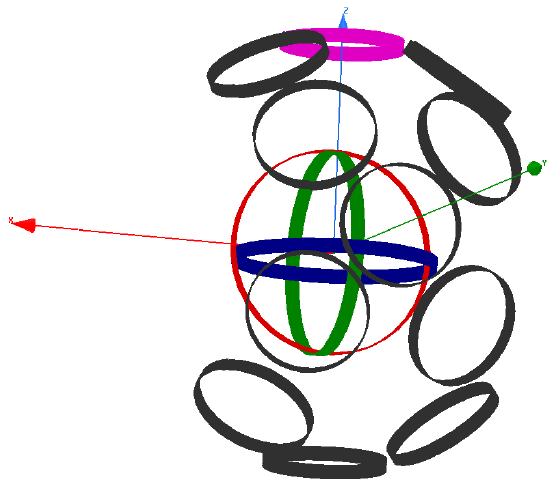
Figure 6. 3D WPT Ansys software simulation when the receiver is rotating in a range of 0° to 360°.